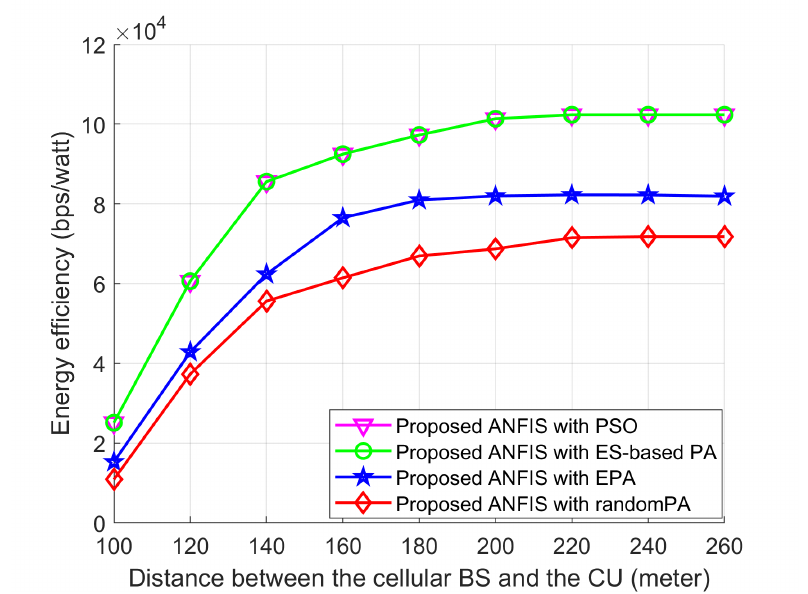
Figure 17. Effect of the power allocation schemes on energy efficiency according to the distance between the cellular BS and the CU when the proposed relay-selection, ANFIS, is used in all power- allocation